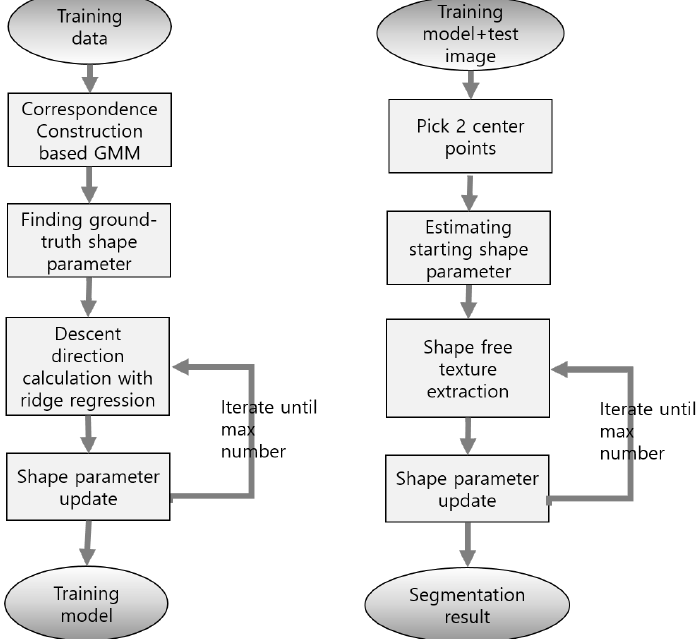
Figure 3. Flow chart of SDM method. Training and test procedure are